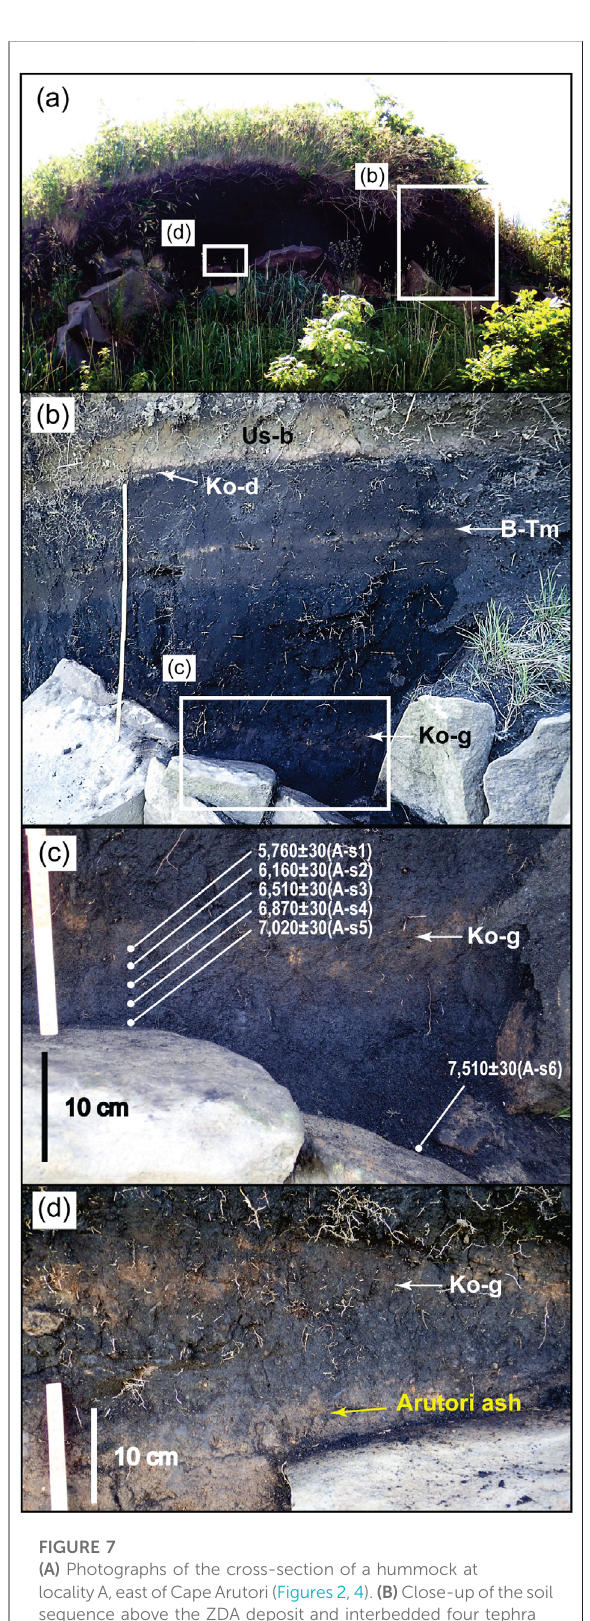
FIGURE 7 (A) Photographs of the cross-section of a hummock at localityA,eastofCapeArutori(Figures2,4). (B) Close-upofthesoil sequence above the ZDA deposit and interbedded four tephra layers, Us-b, Ko-d, B-Tm, and Ko-g, corresponding to the